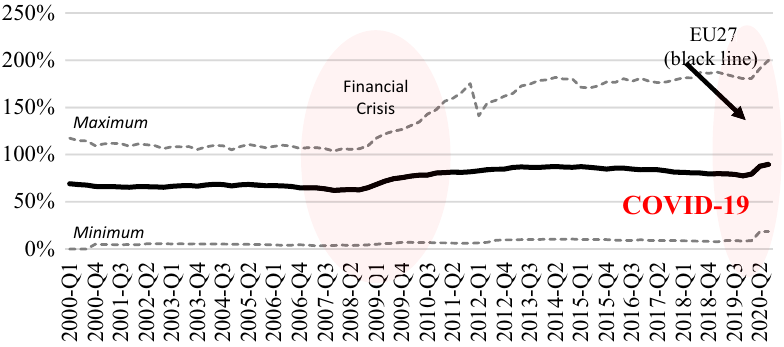
Figure 2: Public debt ( % from GDP ) evolution by quarter ( 2000 – 2020 ) . Source: Authors ’ elaboration based on data from Eurostat. Legend: Maximum – maximum value recorded within EU countries. Minimum – minimum value recorded within EU countries. EU 27 – average at EU 27